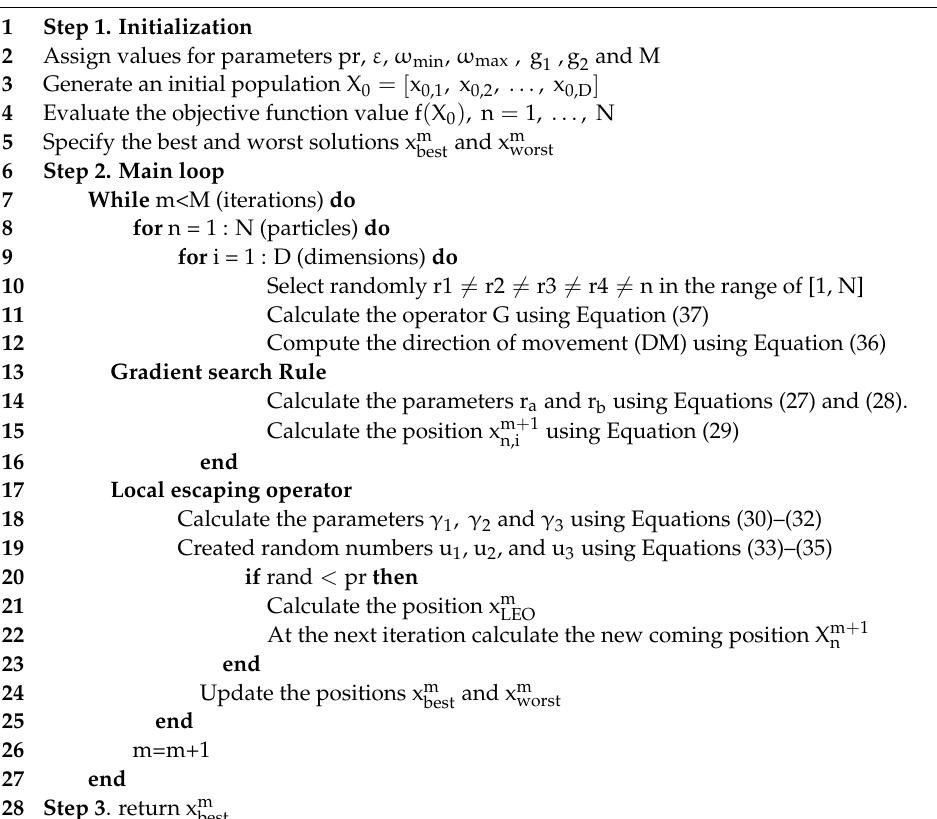
Algorithm 2 . Pseudo code of the IGBO